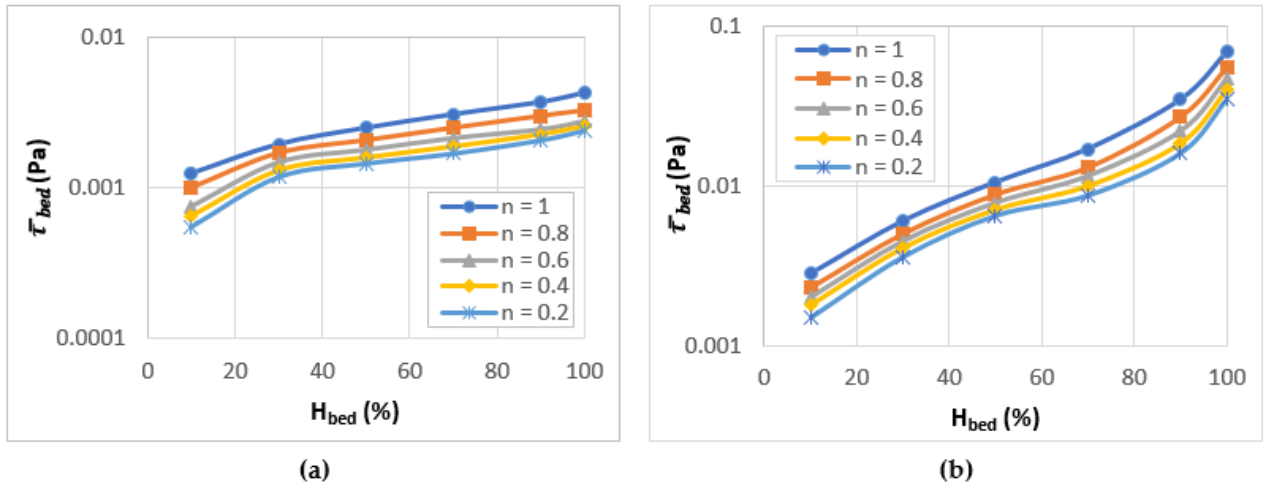
Figure 7. Average bed shear stress vs. bed height for conditions e = 0.9 and 𝑸 = 5 × 10 − 5 m 3 /s and different diameter ratios: ( a ) 𝜿 = 0.25; and ( b ) 𝜿 = 0.75.